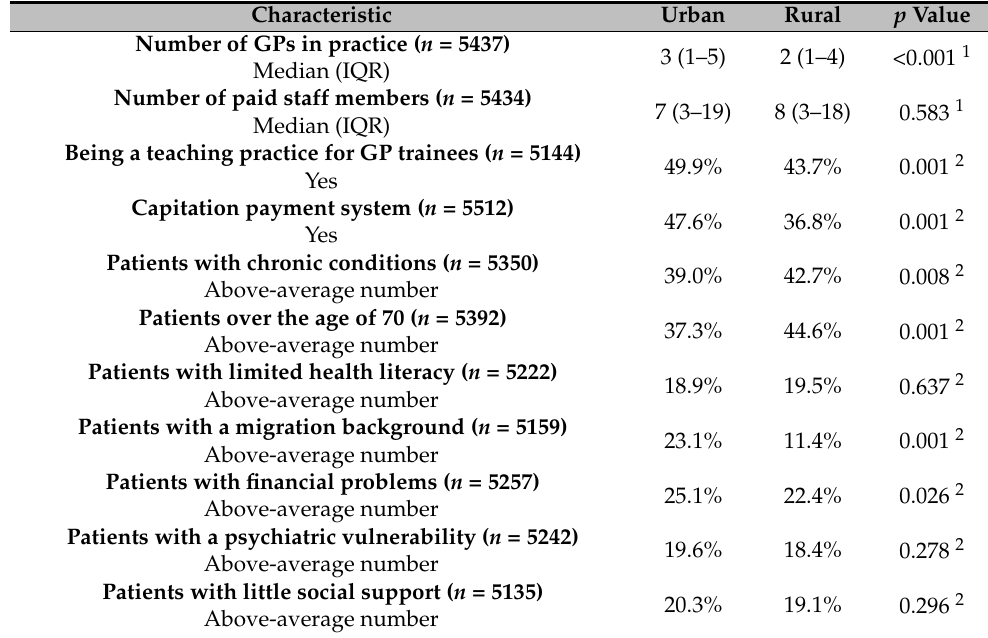
Table 1. Comparison of practice and population profile between urban and rural practice ( n = 5539). Characteristic Urban